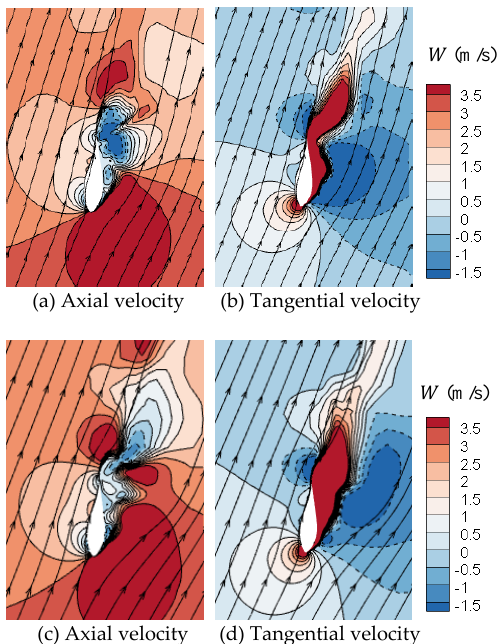
Fig. 14. Contour plots of axial and tangential velocities at r/R = 0.7 for surging turbine when 𝑈 𝑎𝑝 is maximum (a and b, respectively) and when most flow separation occurs (c and d, respectively). Streamlines of the resultant velocity 𝑊 at the blade cross-section are superimposed on the contour plots.